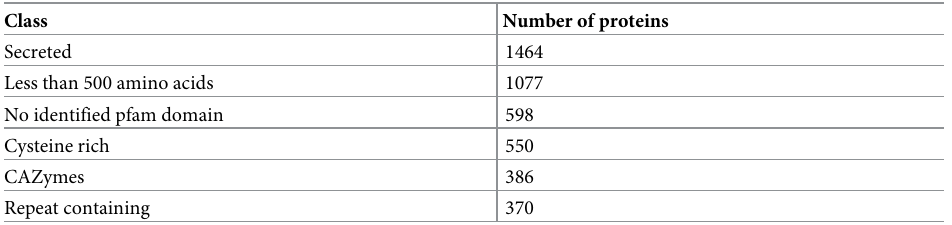
Table 2. Composition of the predicted secretome of F . oxysporum f. sp. Albedinis .